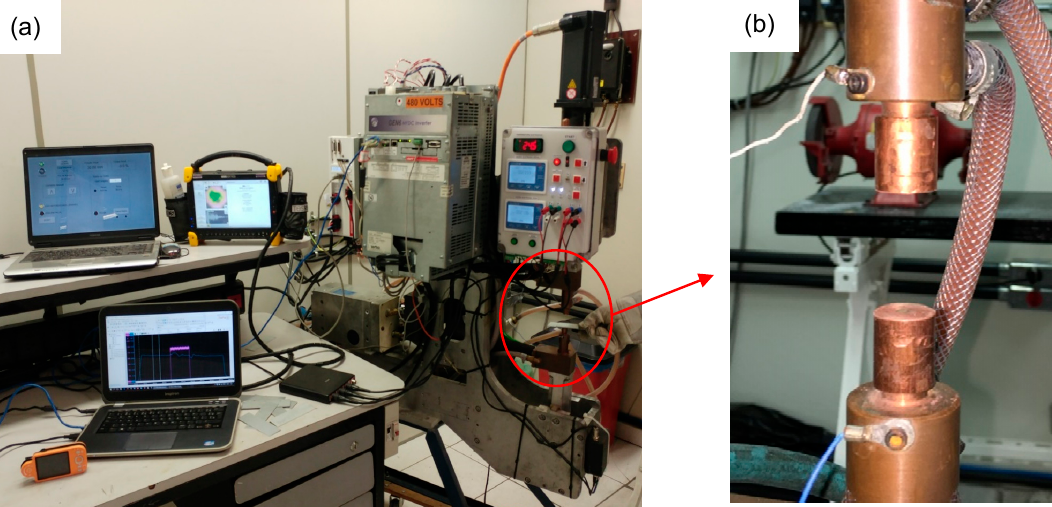
Figure 5. ( a ) Resistance spot welding equipment and accessories, ( b ) the geometry of the contact (electrode/sheet) used during the experiments.